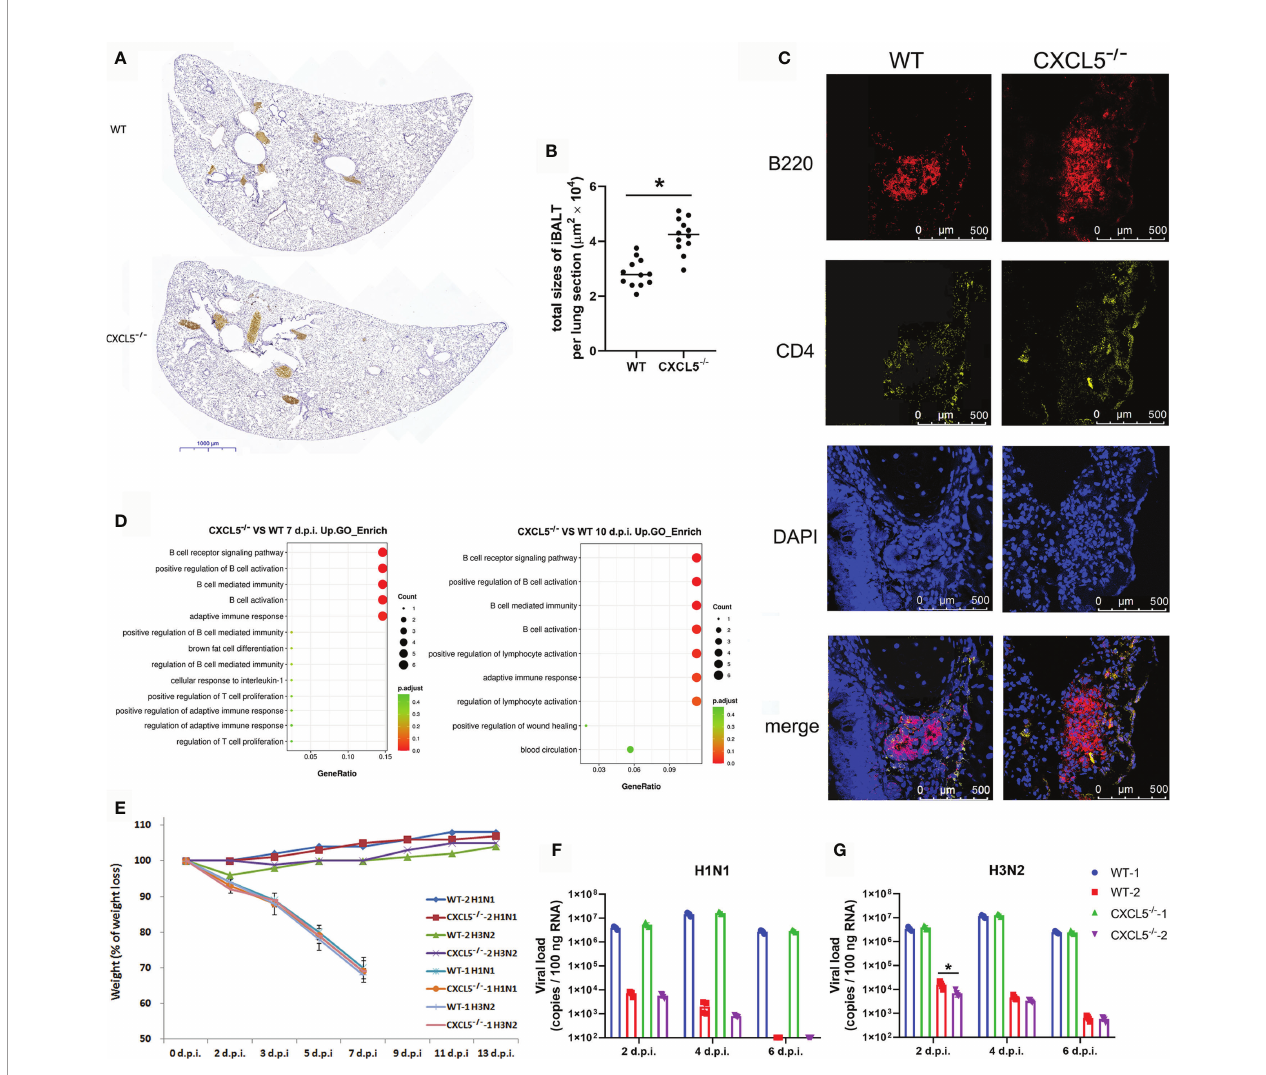
FIGURE 8 | Establishment of adaptive immunity in the infected lungs of WT and CXCL5 -/- mice. (A) Lung lobe sections from WT and CXCL5 -/- mice were stained at 10 d.p.i. with an anti-B220 antibody and hematoxylin (×30 magni fi cation). (B) The positively stained area (iBALT structure) in each lung lobe section was calculated using CaseViewer software (3DHISTECH). The total area of iBALT per lung section was calculated from 4 mice per group (3 lung lobe sections per mouse). (C) Lung sections were stained with anti-B220 (red) and anti-CD4 (yellow) antibodies for immuno fl uorescence detection. The immuno fl uorescence sections were counterstained with DAPI (blue). (D) GO functional analysis of upregulated genes in the infected lungs of CXCL5 -/- mice compared to WT mice at 7 and 10 d.p.i. The methods and criteria for fi ltration of differentially expressed genes are described in the MATERIALS AND METHODS section. (E) Mice were infected with H1N1 or H3N2 (3000 CCID 50 ), and the body weight loss (n=12) of the mice was monitored until 2 weeks post infection. WT-1 H1N1: WT mice infected with H1N1; WT-1 H3N2: WT mice infected with H3N2; CXCL5 -/ – 1 H1N1: CXCL5 -/- mice infected with H1N1; CXCL5 -/ – 1 H3N2: CXCL5 -/- mice infected with H3N2; WT-2 H1N1: WT mice recovered from H1N1 infection and infected with H1N1; WT-2 H3N2: WT mice recovered from H1N1 infection and infected with H3N2; CXCL5 -/ – 2 H1N1: CXCL5 -/- mice recovered from H1N1 infection and infected with H1N1; CXCL5 -/ – 2 H3N2: CXCL5 -/- mice recovered from